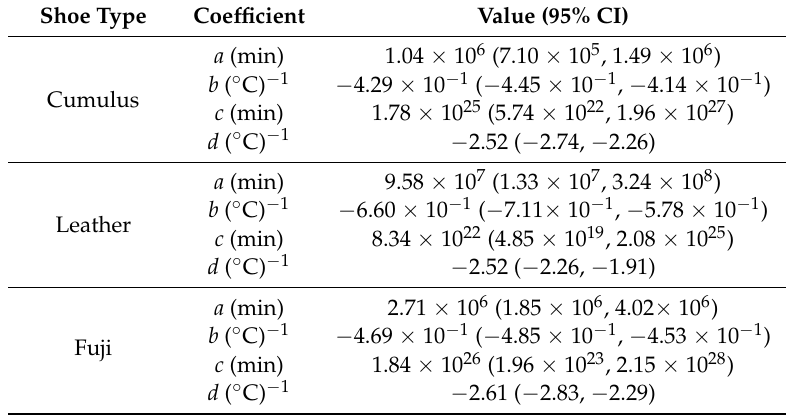
Table 2. Coefficients and associated 95% confidence intervals for the bi-exponential function used to model the cooling process of the three different shoe models used for the experiments (Equation (2)). Values in parentheses indicate the lower and upper limit of the 95% confidence intervals for each